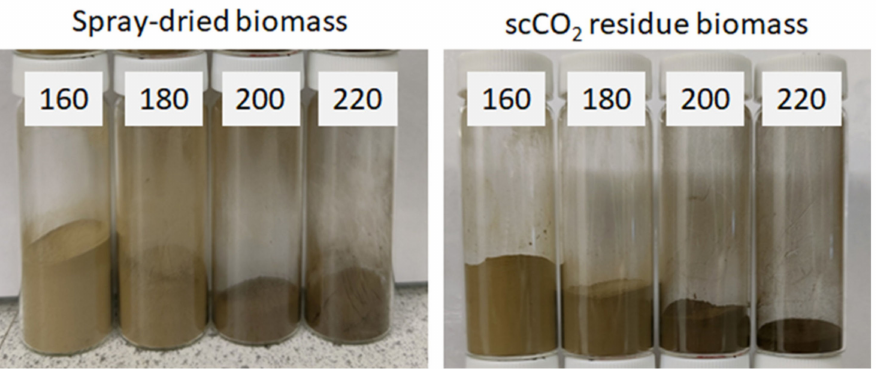
Figure 2. Microfibrillated cellulose (MFC) obtained via microwave treatment at temperatures of 160, 180, 200 and 220 ◦ C for a total of 30 min (50:50 ramp:hold). Obtained from: Left—standard method using spray-dried microalgal biomass. Right: supercritical treated method using residual microalgal biomass post scCO 2 extraction. NB. ‘Standard’ refers to without any scCO 2